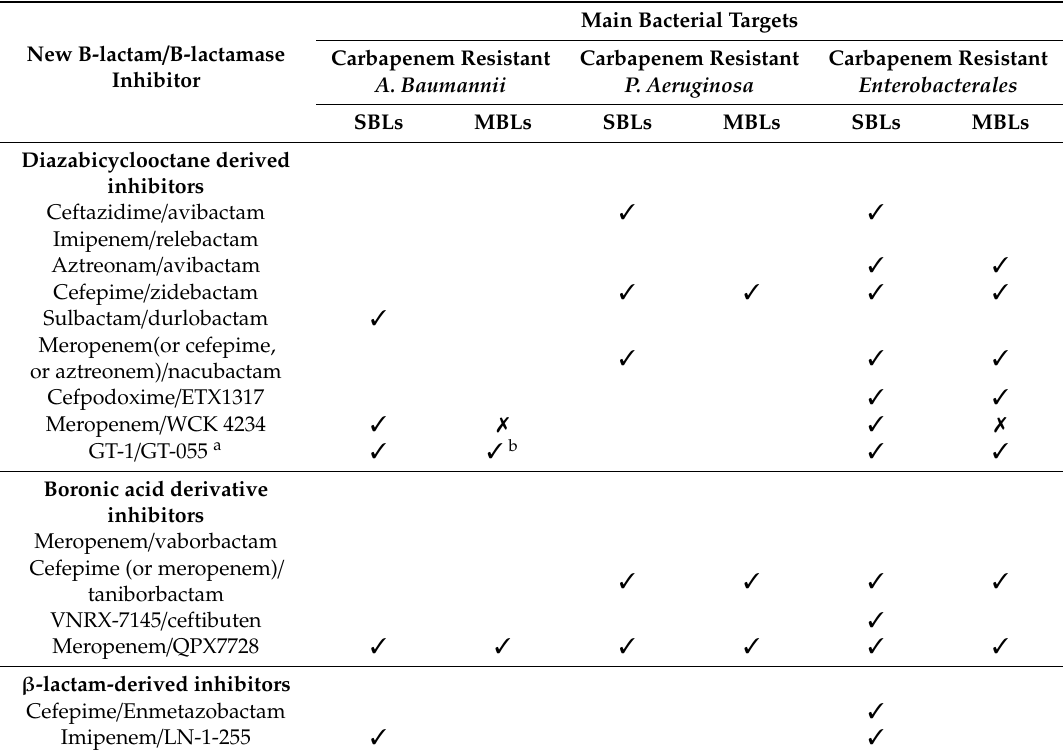
Table 5. Potential therapies aimed at treating infections caused by priority carbapenem-resistant pathogens for which new drugs are urgently